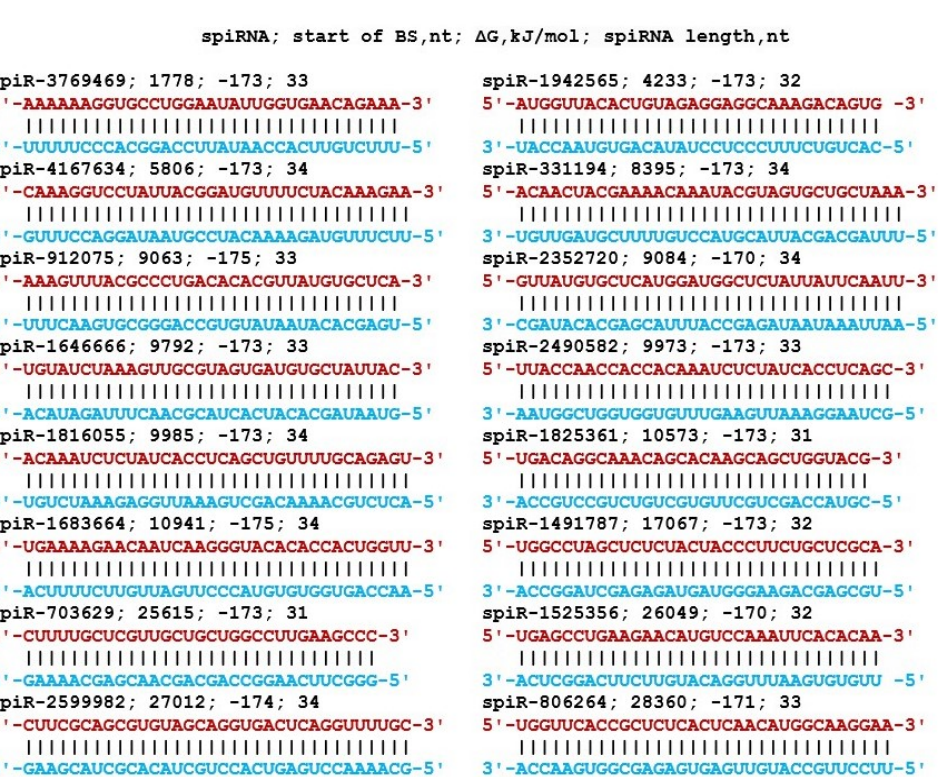
Figure 14. Nucleotide sequences of spiRNAs and characteristics of their interaction in gRNA regions. Note: The gRNA nucleotides of the cluster of spiRNA BSs are highlighted in red. Nucleotides of spiRNAs forming canonical base pairs with gRNA are highlighted in blue.